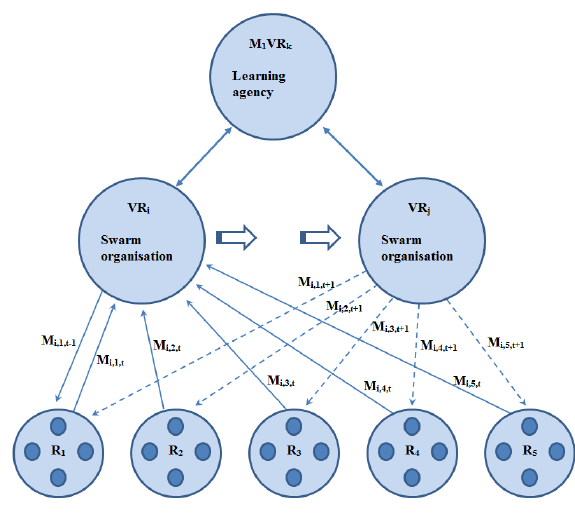
Figure 6: Communication across three levels of a swarm topology, with a swarm consisting of five robots (R one of four possible states). The second level (the VR agency) is the swarm organisation; the third level (the M agency) is the learning framework for the